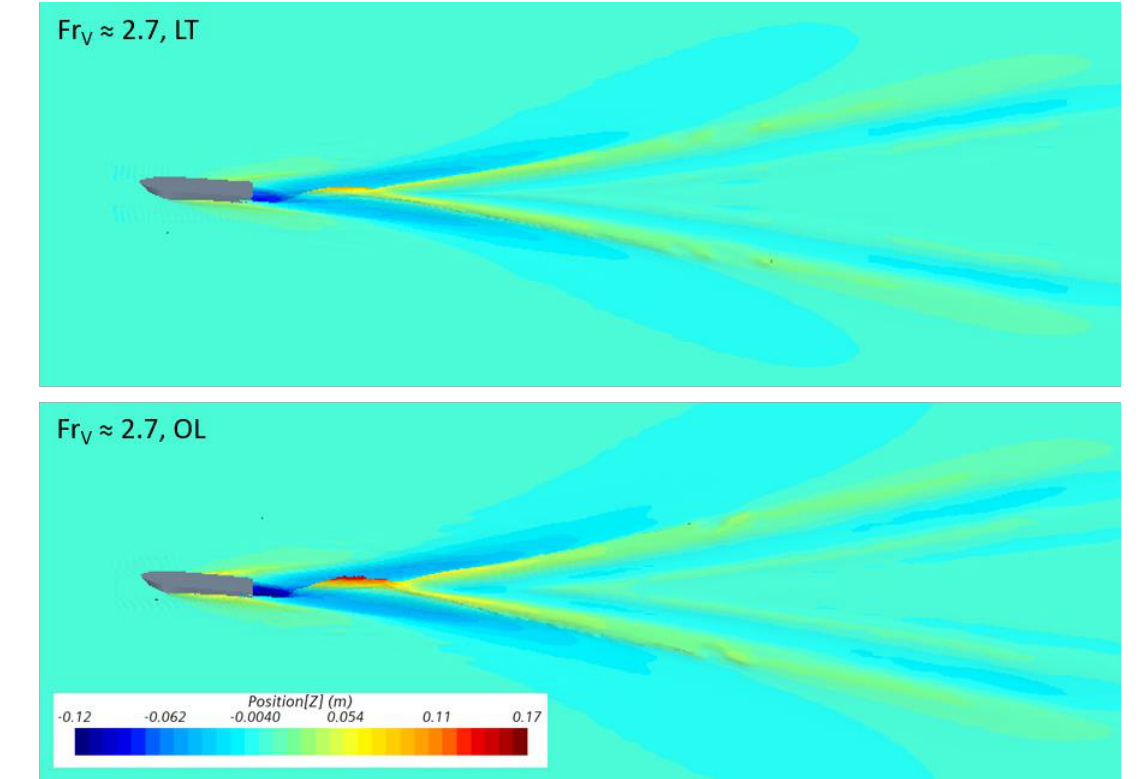
Figure 17. Far-field waves produced by convex-bow hull with LCG = 45% and at Froude number 2.7 for both lighter (LT) and overloaded (OL) configurations.